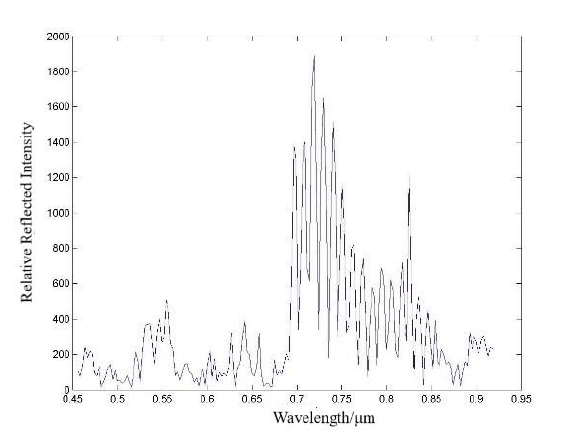
Figure 11. Reconstructed spectrum